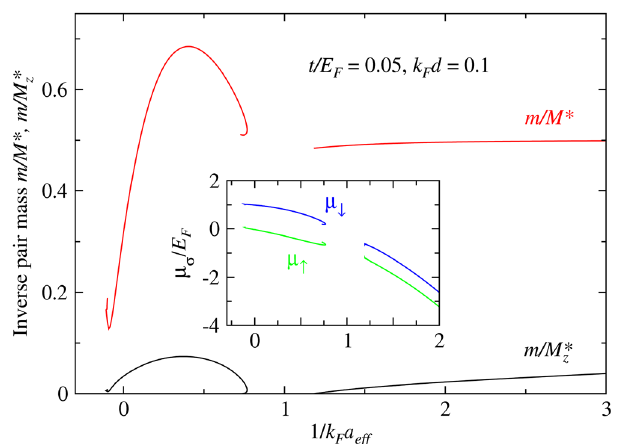
Figure 4. Behavior of the in-plane (red) and out-of-plane (black) components of the inverse pair masses (main panel) and chemical potentials (inset, μ ↑ and μ ↓ , as labeled) as a function of k a 1/ k F d = 0.1. The sign changes in m/M z * lead to pair density wave ground state in between, exhibiting reentrant superfluidty. Here M * ≡ M ǁ*